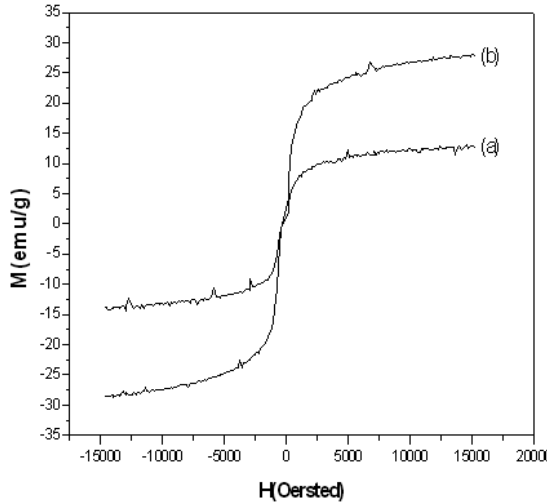
Fig. 6 – Magnetization curves of the samples coated with hydroxyapatite: (a) IOMP/HAp = 0 . 7; and (b) IOMP/HAp . = 3